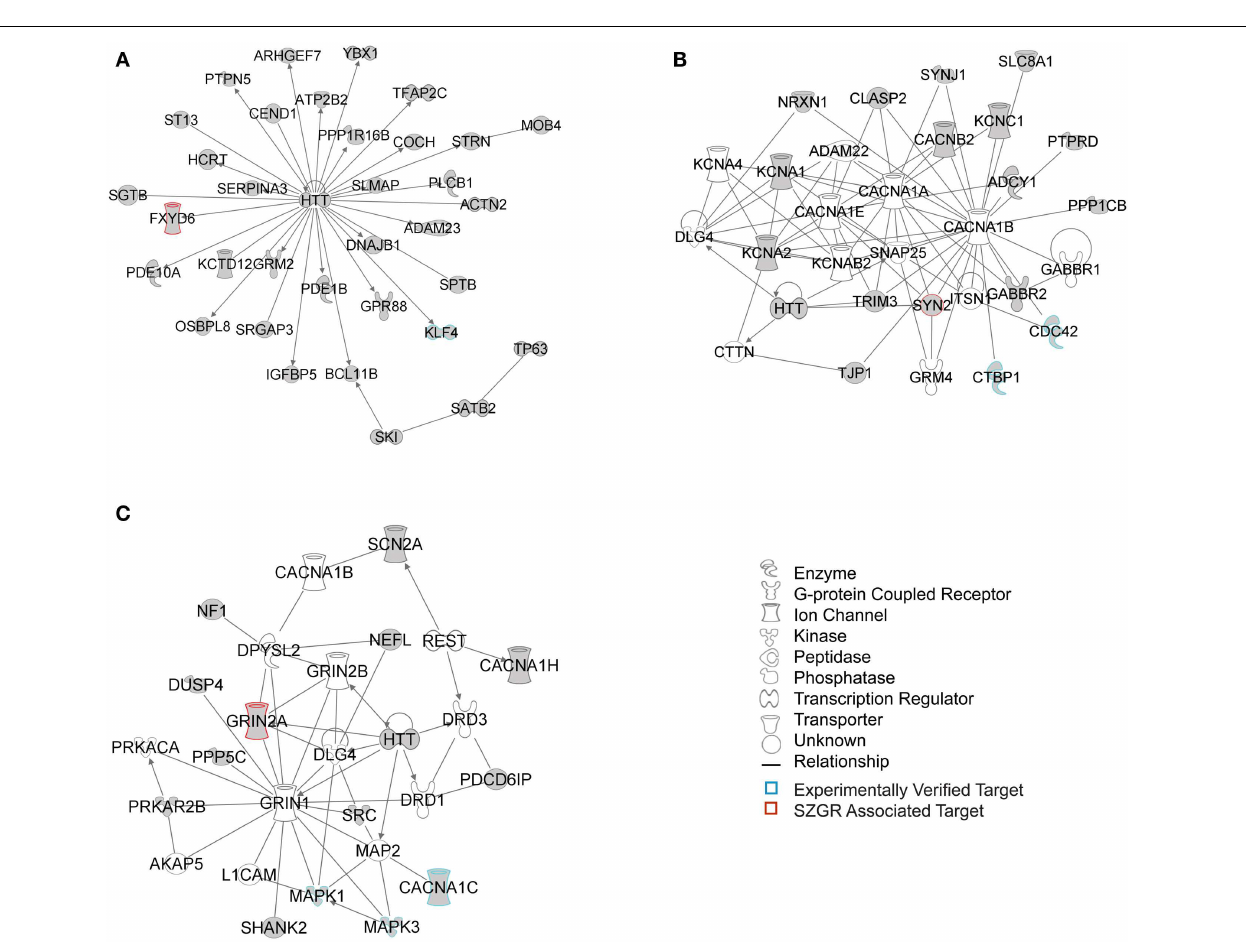
FIGURE 6 |Top 3 scoring IPA network analysis generated networks for the 929 nervous tissue specific putative and verified targets .The top 3 scoring networks identified by this analysis were: (A) “hereditary disorder, neurological disease, skeletal and muscular disorders,” with a score of 35, (B) “neurological disease, cell-to-cell signaling and interaction, nervous system development and function,” with a score of 10, and (C) “behavior, cell-to-cell signaling and interaction, nervous system development and function,” with a